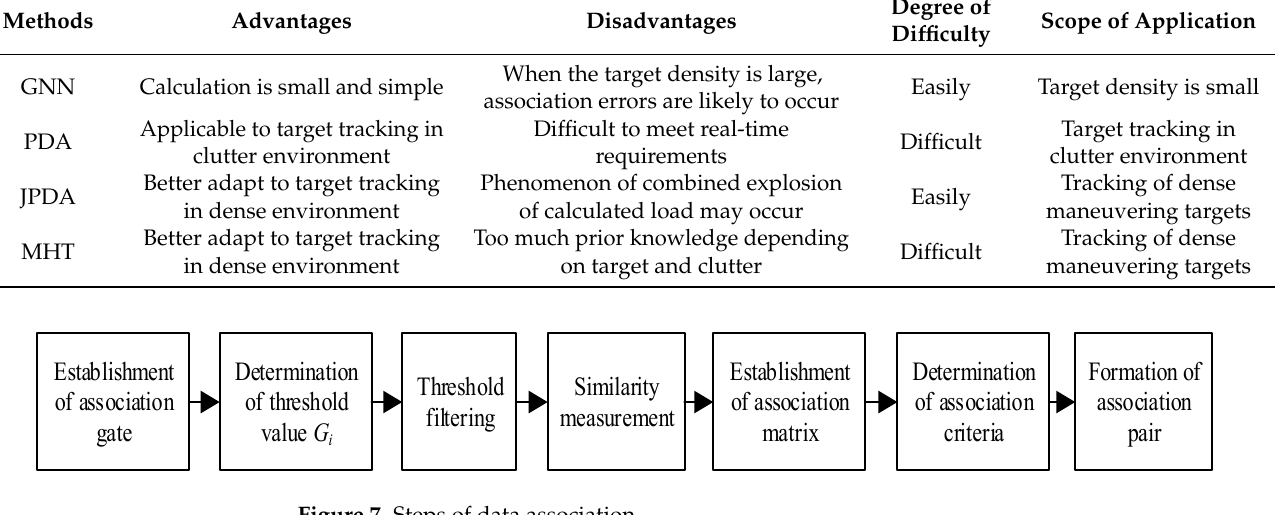
Figure 7. Steps of data association.